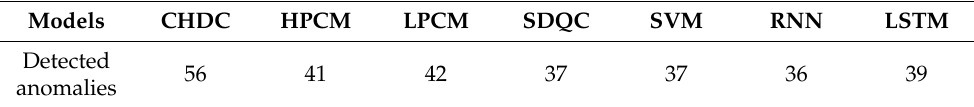
Table 2. Detected anomalies of different methods for the Guxiandu Station.